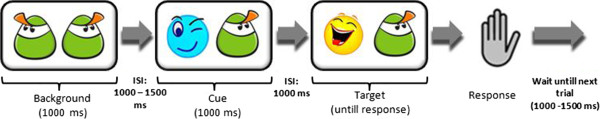
Stimuli of cue-target paradigm. Schematic of the cue-target paradigm shown on the left side of the screen. For presentation on the right side, the smiley figures were mirrored horizontally.